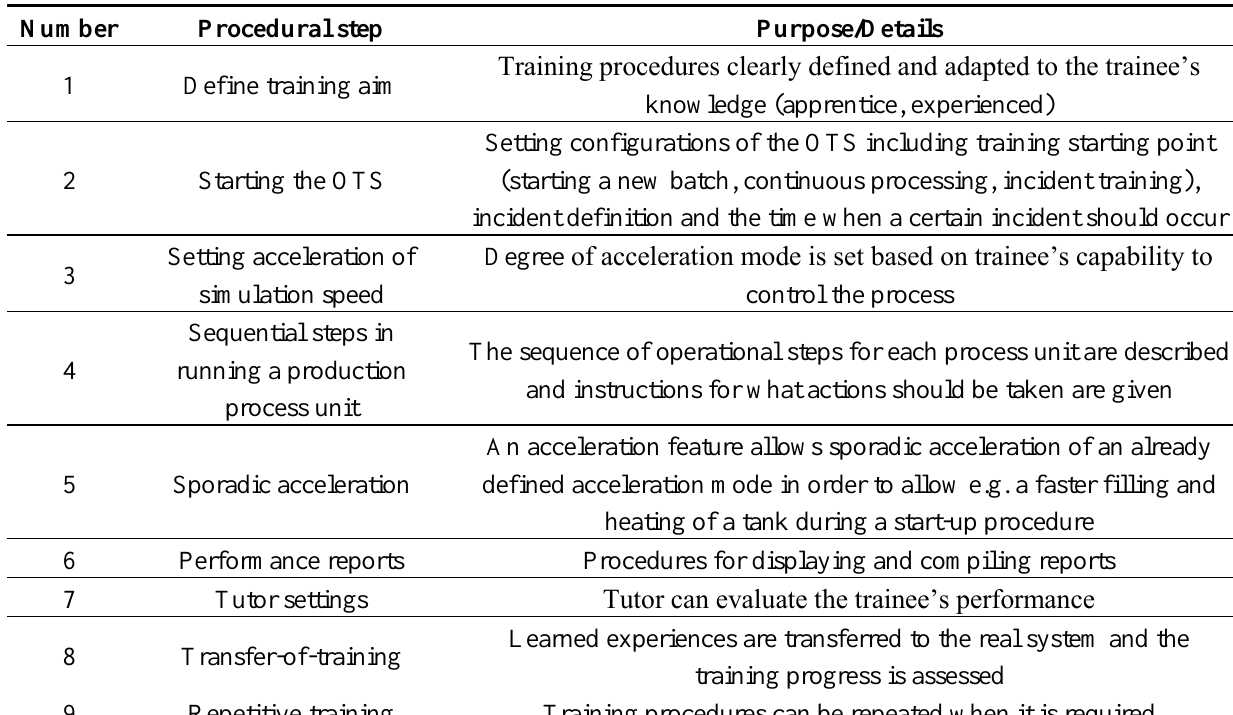
Table 3. Operational procedures as part of an OTS training